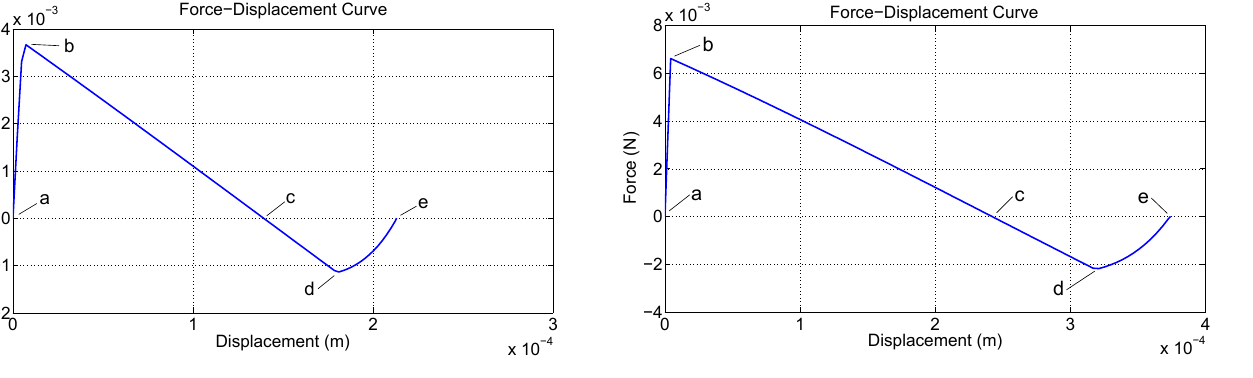
Figure 2. Force vs. displacement curve for a single flexural beam angled at 8 ◦ . (a) First stable position (fabricated position). (b) Switching force from position 1 to position 2. (c) Unstable equi- librium point. (d) Switching force from position 2 to position 1. (e) Second stable position.